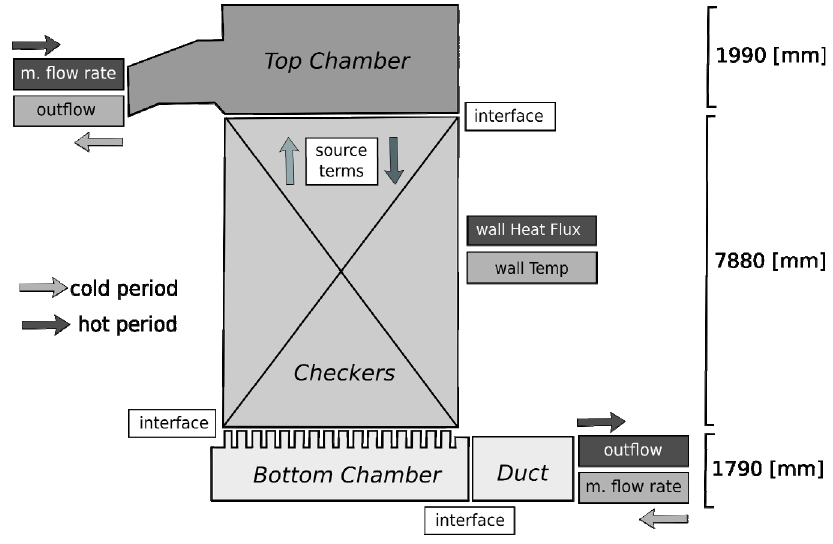
Figure 5. Schematic view of the regenerator structure with the relevant boundary